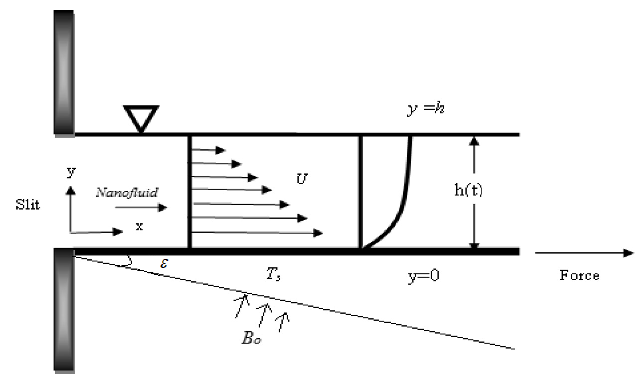
Figure 1. The flow geometry of the model.